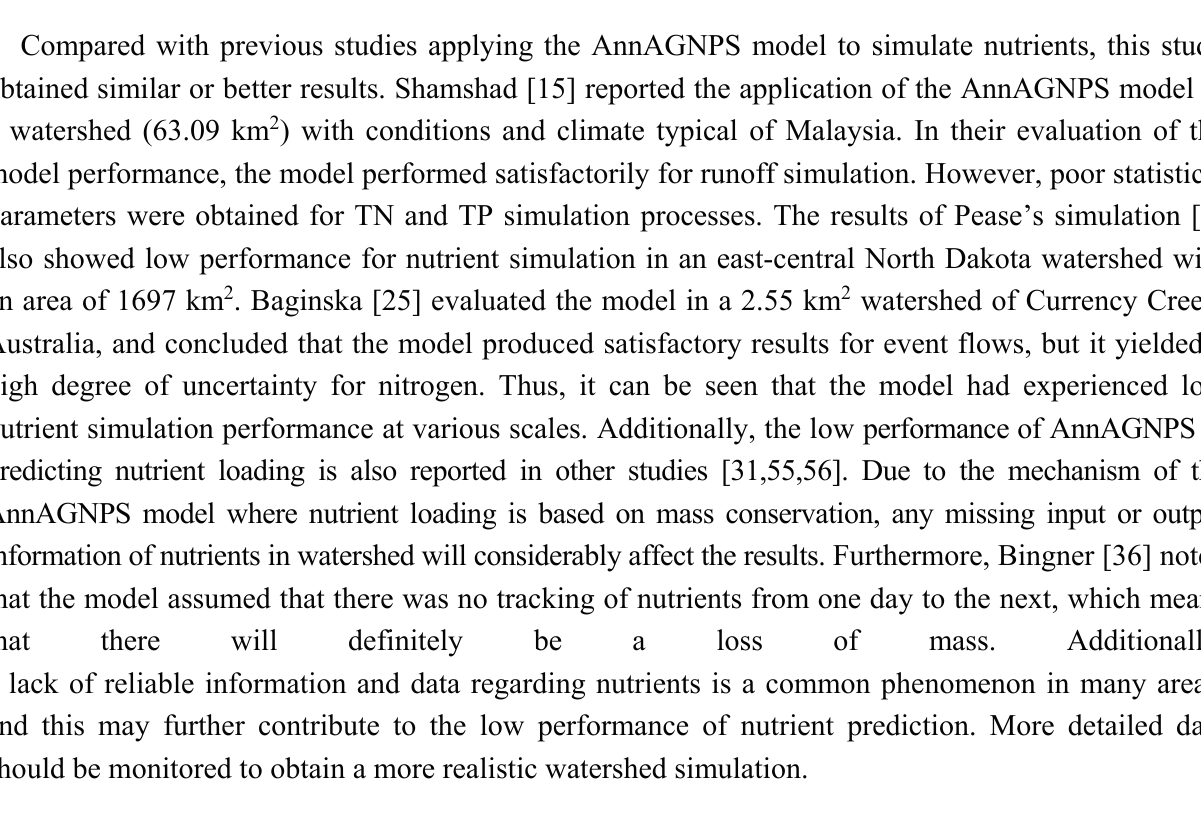
Figure 8. Comparison between observed and simulated TN ( left ) and TP ( right ) loading during the validation